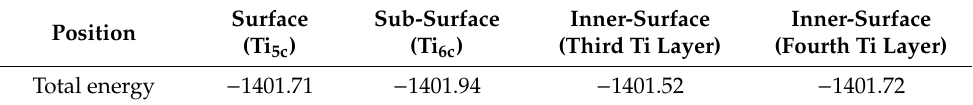
Table 3. Total energy (in eV) of CH 3 NH 3 PbI 3 / TiO 2 with substitution of one Nb 5 + for Ti 4 + .